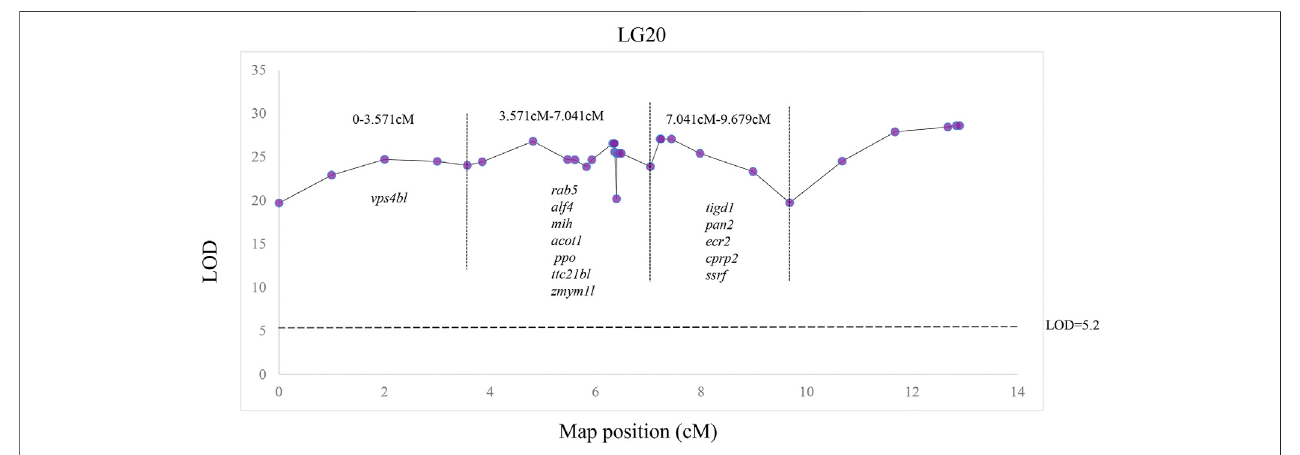
FIGURE 5 | Distribution of 2b-RAD-seq SNP markers and candidate sex dimorphic genes in LG20.